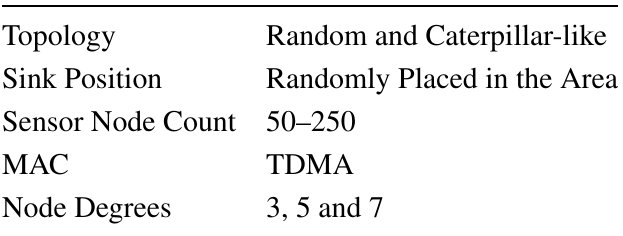
Table 6. Simulation